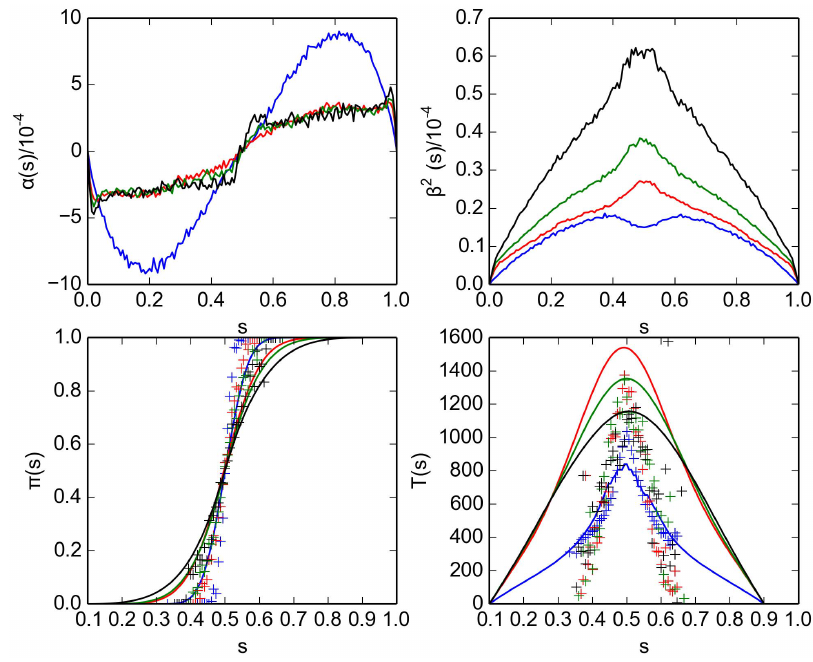
Figure 6. Comparison of swarm properties for different values of the avoidance radius d a . Shown are results for d a ~ 0 : 01 (blue curves and markers), d a ~ 0 : 05 (red curves and markers), d a ~ 0 : 075 (green curves and markers) and d ~ 0 : 1 (black curves and markers). All other simulation parameters are given in Table 1. (top panels) Parameters a ( s ) (left) and b 2 ( s ) (right) for the stochastic differential equation as inferred from the simulation results for the virtual swarm. (bottom left panel) Splitting probability p ( s ) , as estimated directly from the simulation output [cf. Eq. (53)] (markers) and computed using the integrated stationary distribution Eq. (54) (curves). (bottom right panel) Decision time T ( s ) as estimated from the simulation output [Eq. 58] (markers) and computed from the FPE coefficients [Eq. (59)] (curves).